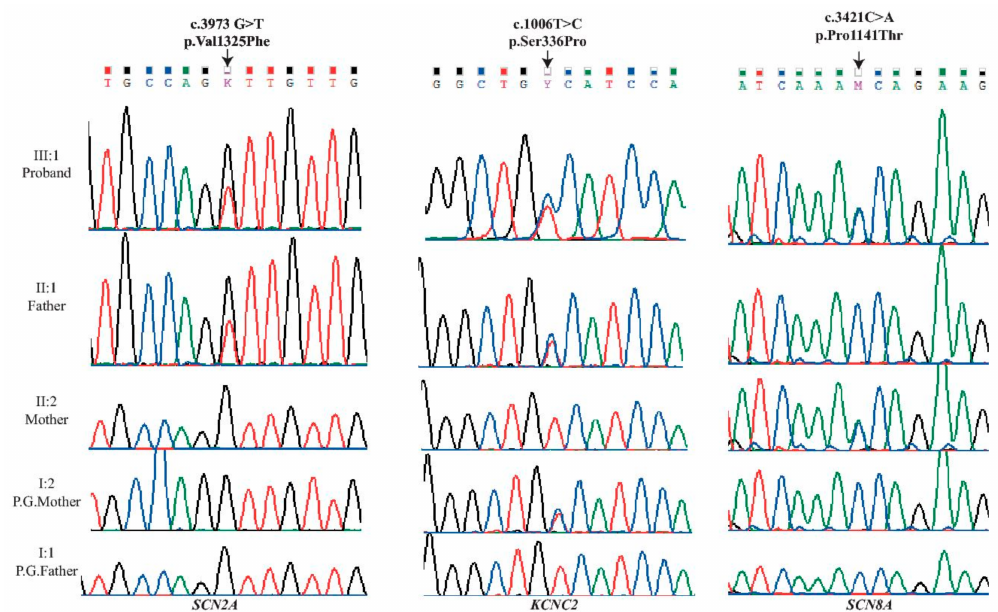
Figure 1. Sequencing of three novel mutations identified in Sodium channel α 2-subunit ( SCN2A-left ), Potassium channel, Kv3.2 ( KCNC2-middle ) and Sodium channel Nav1.6 ( SCN8A-right ) genes. Data were obtained by Chromas (from Sanger sequencing) and the Integrative Genomics Viewer (from the WES) during the confirmation process. The three heterozygous exonic point variants; left c.3973G>T: p.Val1325Phe in exon 21 of the SCN2A gene, middle c.1006T>C: p.Ser336Pro in exon 3 in the KCNC2 gene; and right c.3421C>A: p.Pro1141Thr in exon18 in the SCN8A gene; All were sequenced in the five family members.